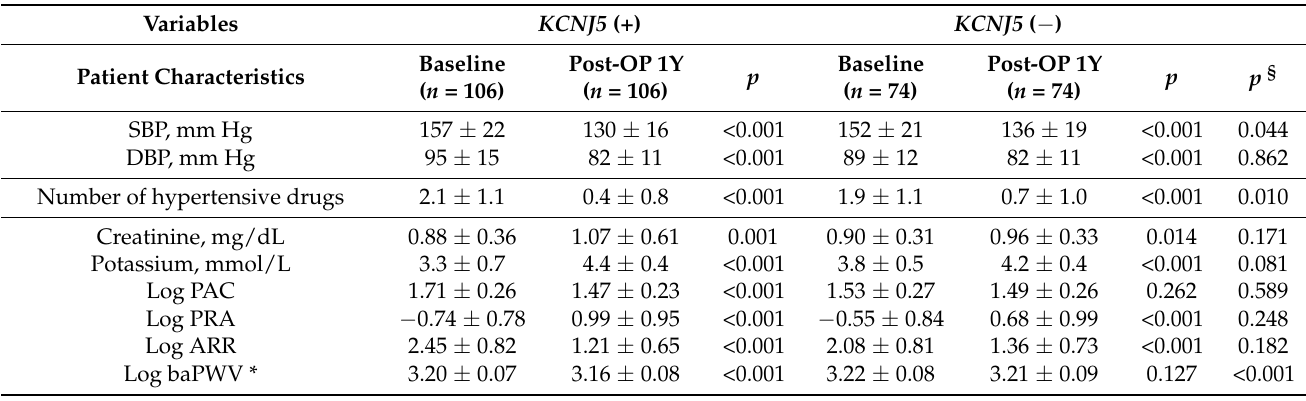
Table 3. Paired comparisons of clinical data and pulse wave velocity data of all patients before and after adrenalectomy according to the status of KCNJ5 mutations and the comparisons of parameters after operations between APA patients with and without mutations.